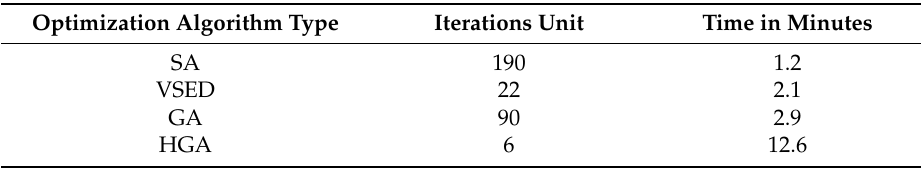
Table 8. Comprehensive obtained performance between optimization